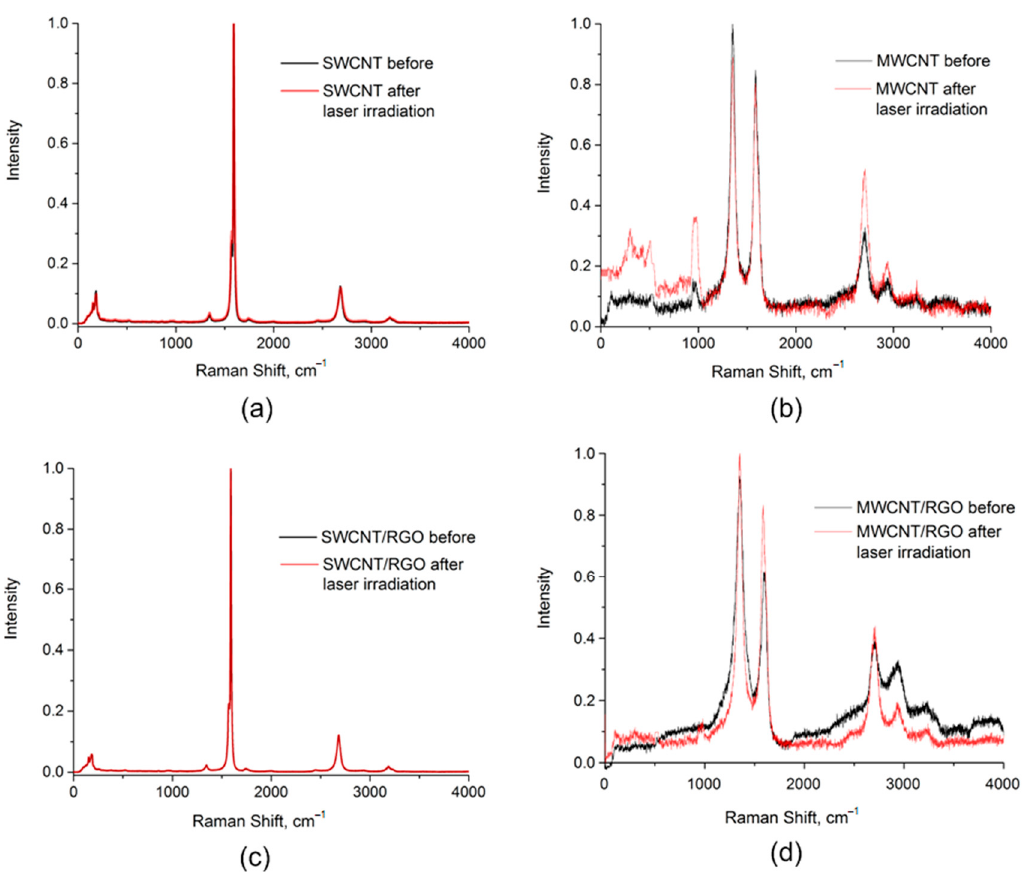
Figure 7. Raman spectra of ( a , b ) CNT and ( c , d ) CNT/rGO hybrids before (black line) and after (red line) laser irradiation with energy density ( a , c ) 0.3 J/cm 2 for SWCNT and SWCNT/rGO, ( b , d ) 0.5 J/cm 2 for MWCNT and MWCNT/rGO. Table 2. Characteristic bands of Raman